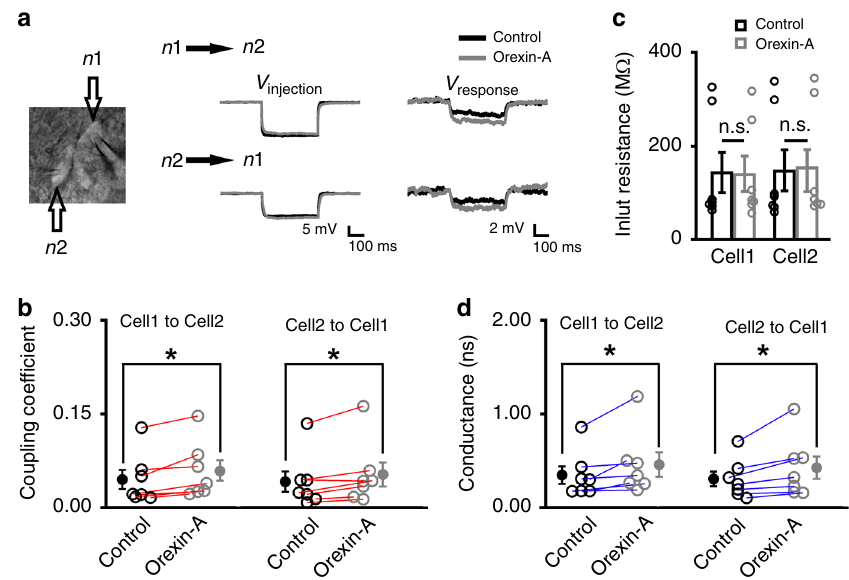
Fig. 4 Orexin increases the GJ conductance in coupled SLD neurons. a (Left) Double patch-clamp recordings in a pair of electrically connected SLD neurons in rat. (Right) Representative traces from this electrically connected pair of neurons showing that similar amplitude of voltage change in n1 ( V injection ) induced larger voltage response ( V response ) in n2 in the presence of orexin-A (100 nM), and vice versa. b Group data showing that orexin-A bilaterally increased the coupling coef fi cient from cell 1 to cell 2 (left, two-sided Wilcoxon signed-rank test; z = 2.366, P = 0.0180) and cell 2 to cell 1 (right, two-sided Wilcoxon signed-rank test; z = 2.197, P = 0.0280) ( n = 7 pairs of neurons). c Group data showing that the input resistances of cell 1 (left, two- sided Wilcoxon signed-rank test; z = 0.338, P = 0.735) and cell 2 (right, two-sided Wilcoxon signed-rank test; z = 1.690, P = 0.0910) were not affected by orexin-A ( n = 7 pairs of neurons). d Group data showing that orexin-A bilaterally increased the GJ conductance from cell 1 to cell 2 (left,